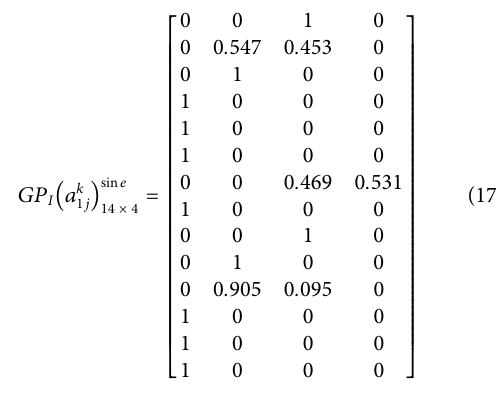
FIGURE 4 Index weights calculated through linear membership